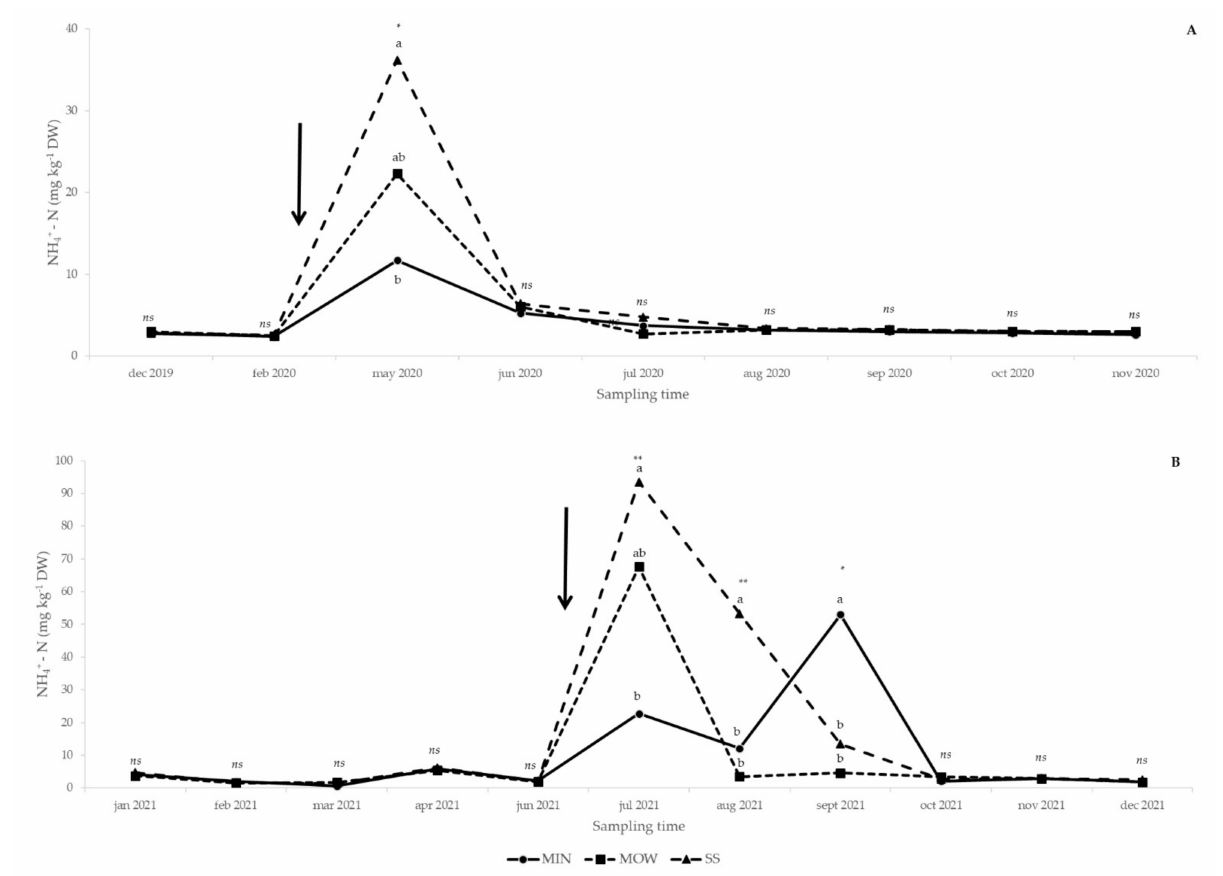
Figure 2. Effect of fertilization treatments on soil ammonium-N (NH 4+ -N) concentration from Decem- ber 2019 to December 2020 ( A ) and from January 2021 to December 2021 ( B ). Arrows: amendment applications (20 April 2020 and 17 June 2021). MIN: mineral; MOW: municipal organic waste compost; SS: sewage sludge compost. ns , *, **: effect not significant or significant at p ≤ 0.05 and p ≤ 0.01, respectively. Means followed by the same letter are not statistically different ( p ≤